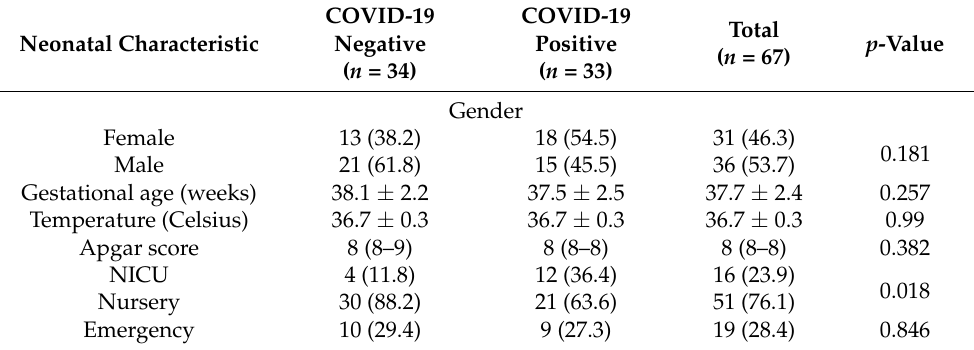
Table 4. Neonatal characteristics and main outcomes.